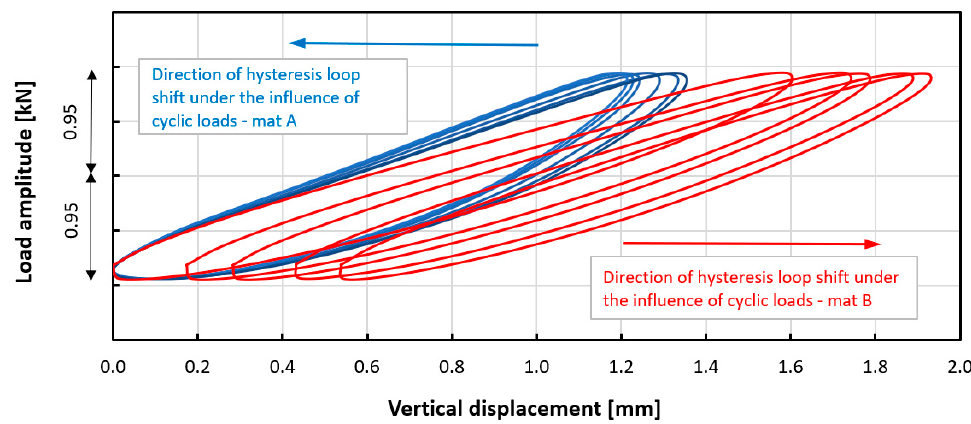
Figure 7. Comparison of experimental curves showing the effect of the number of load cycles on the dynamic response of both types of mats, dynamic creep phenomenon can be observed for Mat B (hysteresis loops transformed to mean load value = 0). Table 5. Experimental results of the dynamic bedding modulus C dyn as a function of the number of load cycles for Mat A.